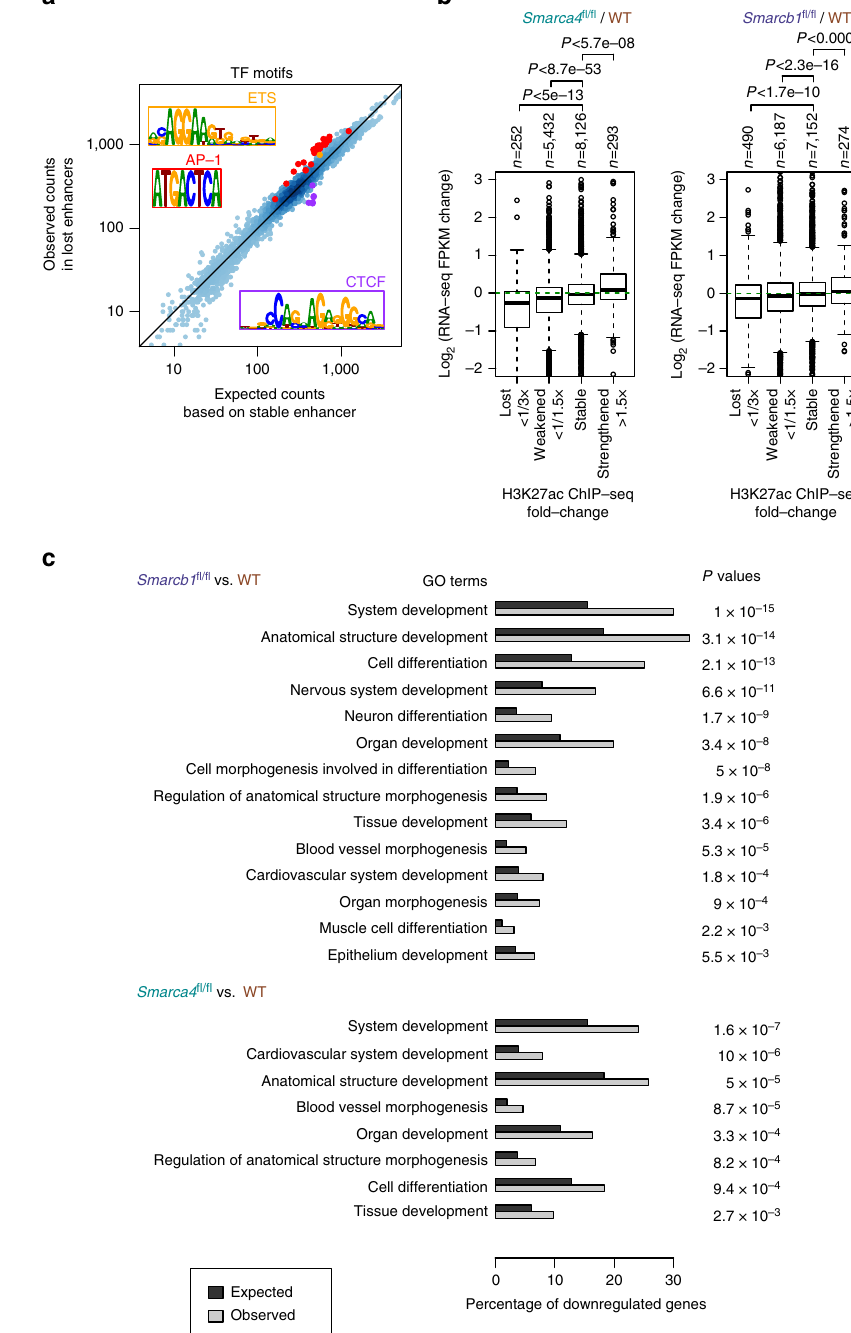
of the target subunit was mated to a cre transgenic mouse. This yields B 50% of the offspring as heterozygous for the loxP allele and hemizygous/heterozygous for the cre transgene. Then, these mice were mated back to the homozygous loxP -flanked mice. Approximately 25% of the progeny from this mating are homozygous for the loxP -flanked allele and hemizygous/heterozygous for the cre transgene. We checked the genotype for each target subunit gene as well as Cre by PCR.